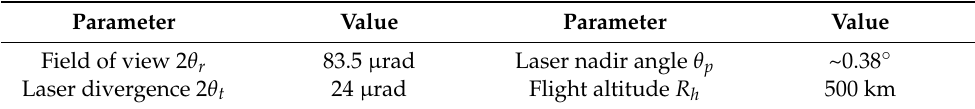
Table 1. System parameters of ICESat-2 used in this study [39,40]. Parameter Value Parameter Value Field of view 2 θ r 83.5 µ rad Laser nadir angle θ p ~0.38 ◦ Laser divergence 2 θ t 24 µ rad Flight altitude R h 500 km